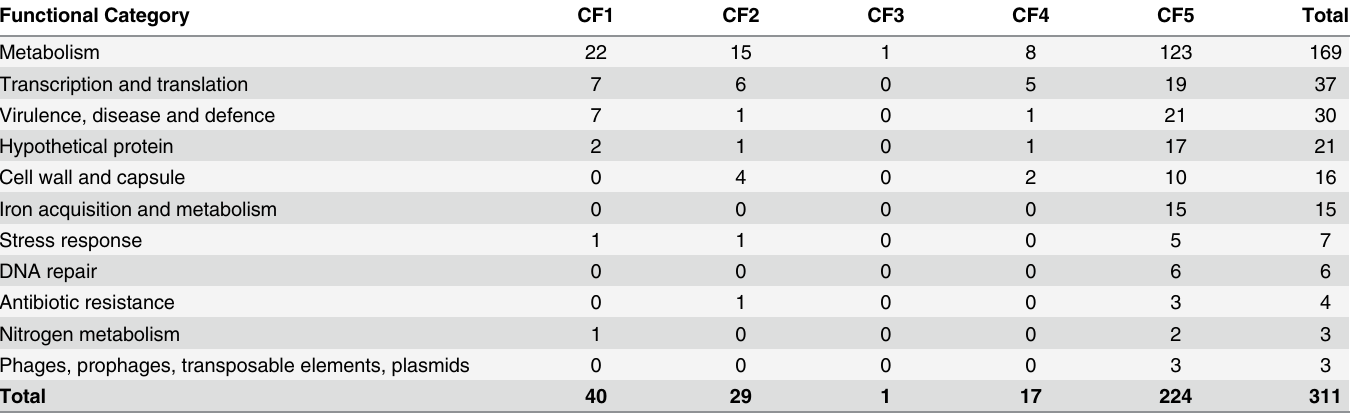
Table 4. Mutated genes (N = 311) grouped according to functional category (RAST). The number of mutated genes in each category is listed for clones from each of the five patients. Functional